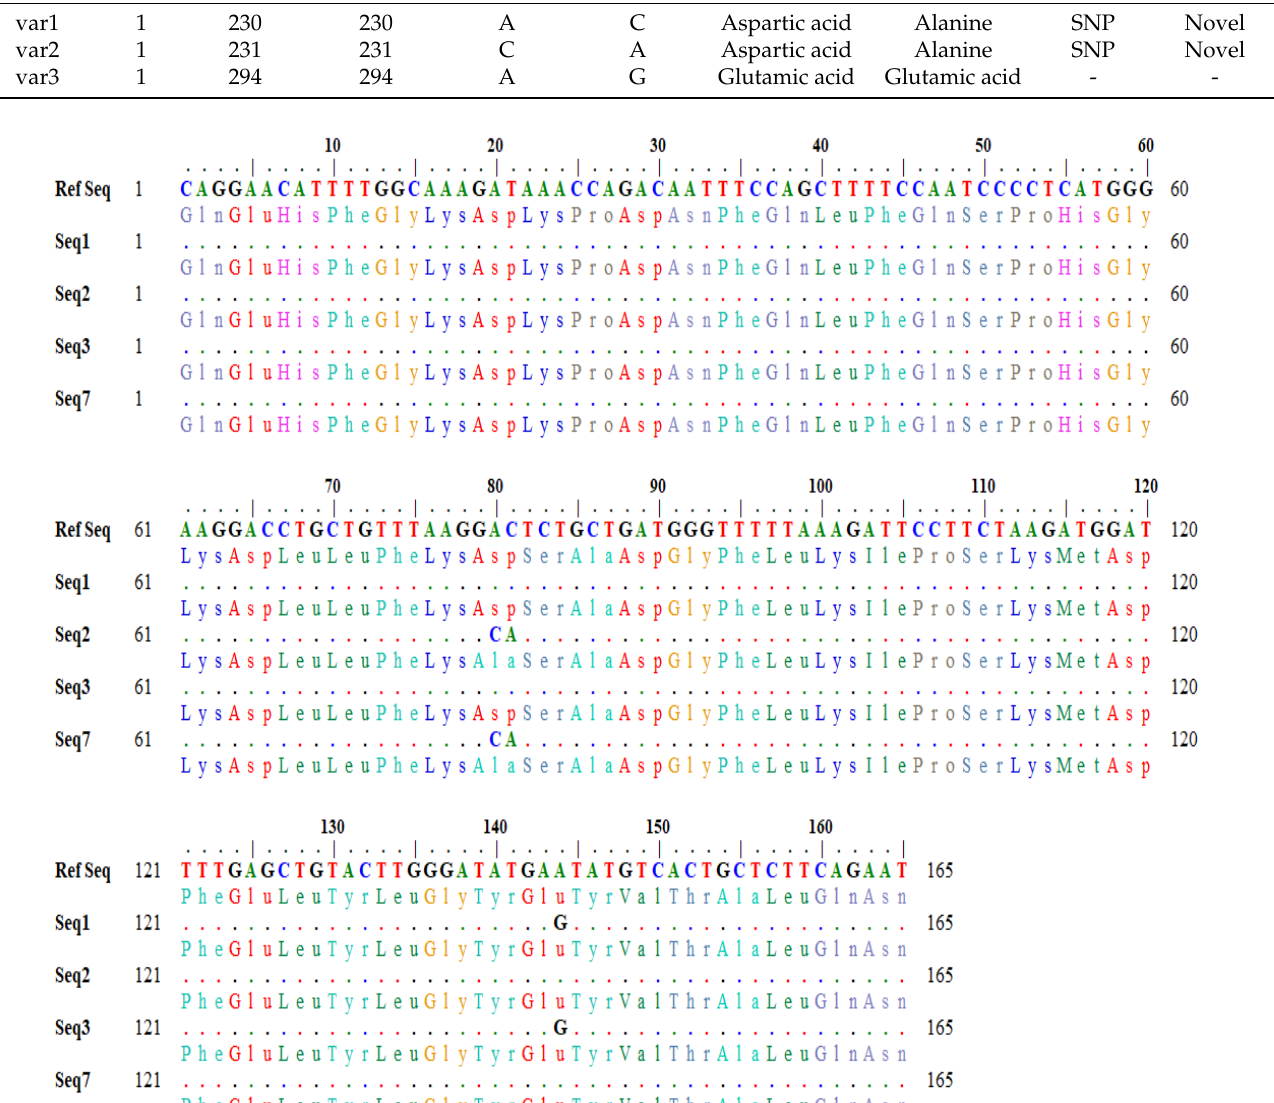
Table 7. Amino acid variation in subject and query protein